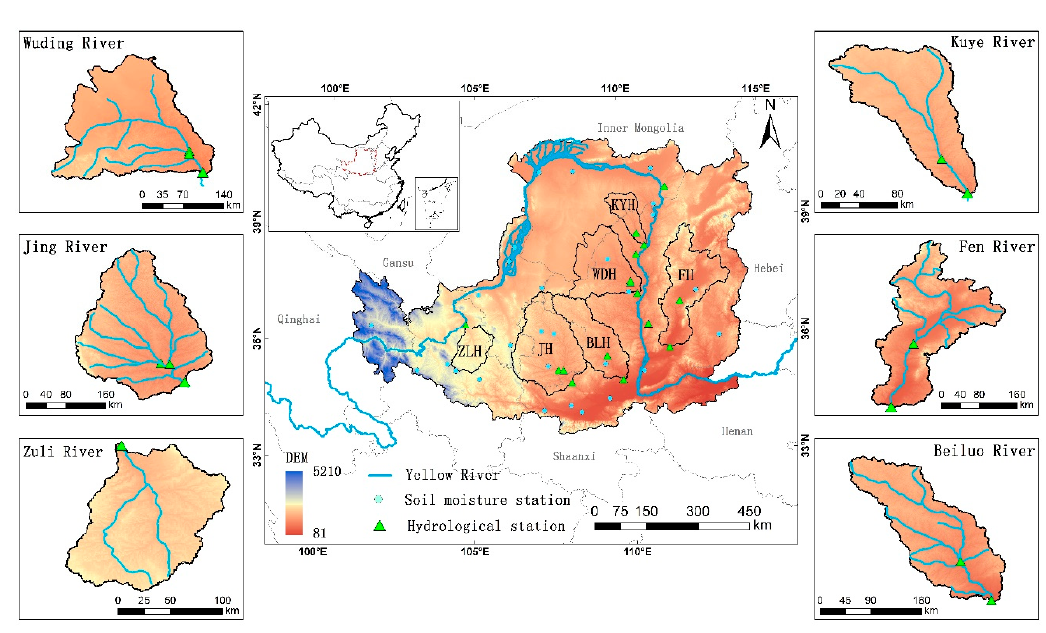
Figure 1. The Loess Plateau and six selected catchments.